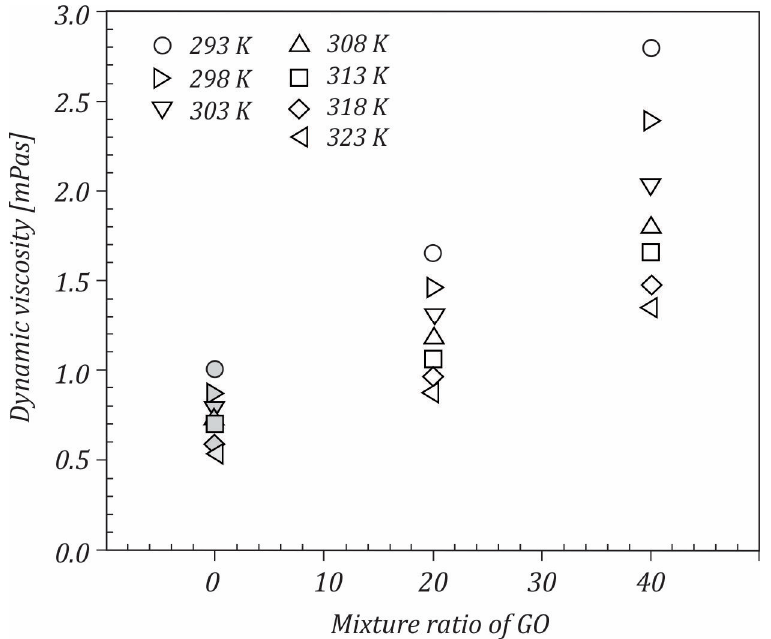
Figure 6. Variation of dynamic viscosity with the mixture ratio of GO sheets.